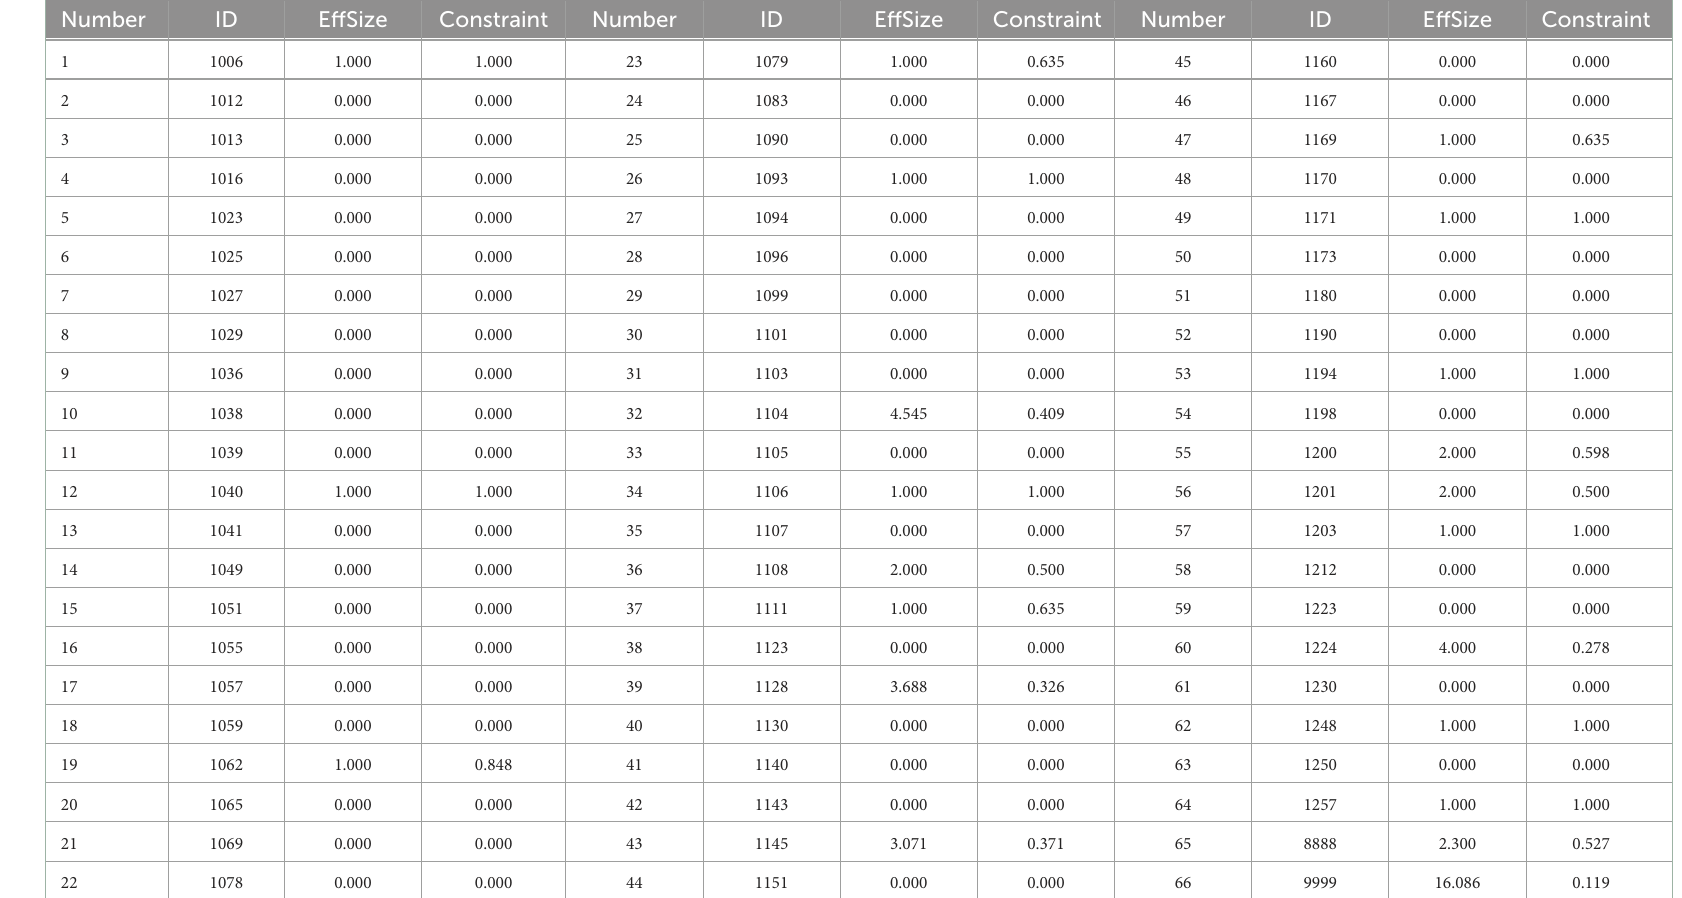
TABLE 5 The structural hoes of control